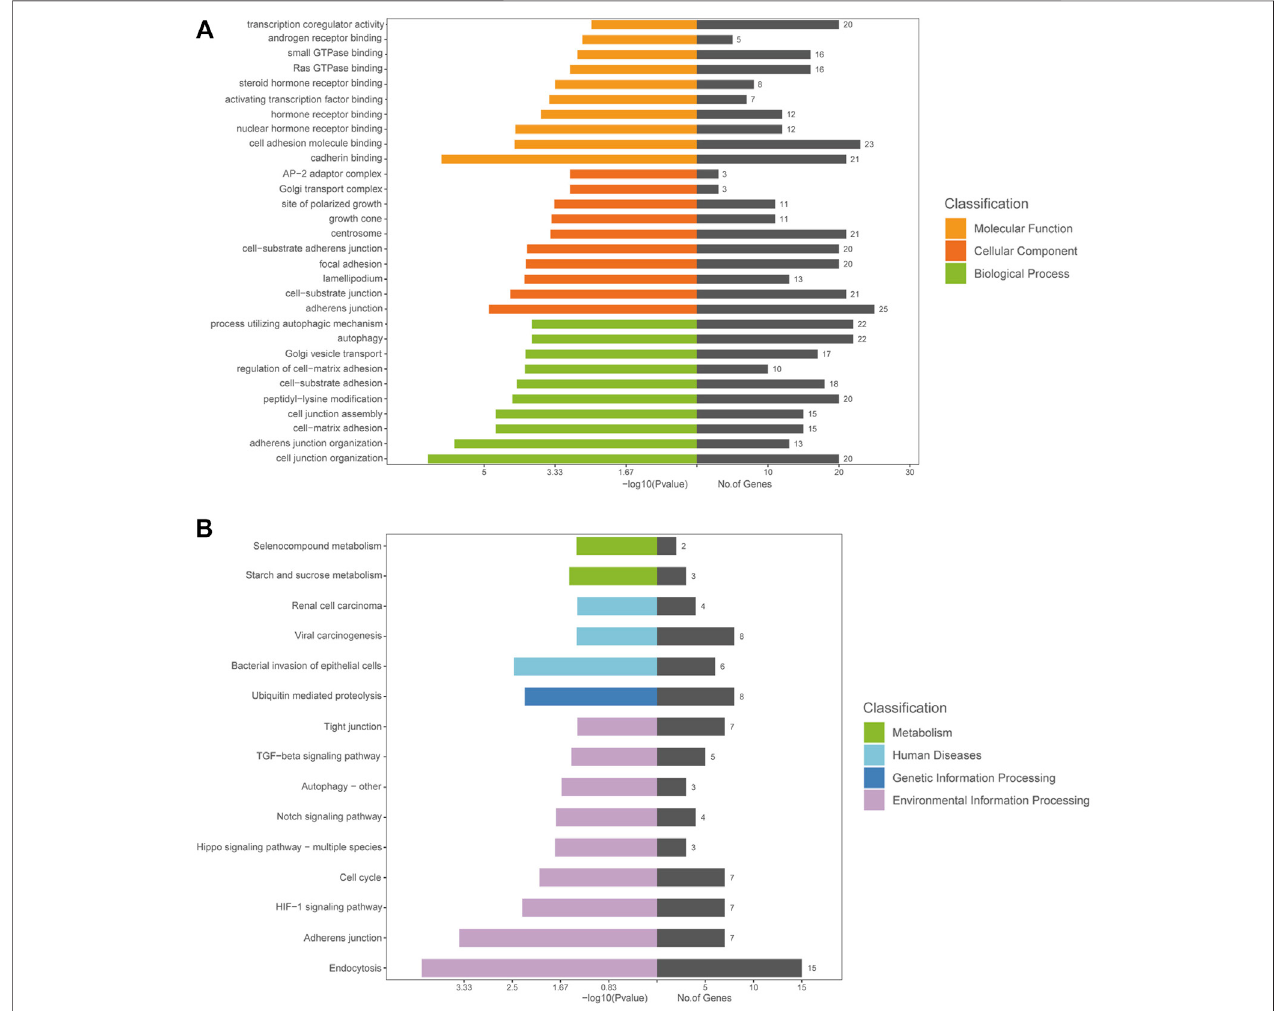
FIGURE 3 | GO and KEGG analyses of the host genes of DE circRNAs in AS-BMSCs. (A) . GO annotations of the host genes of DE circRNAs. The left bar plot presents the enrichment scores [ − log 10 ( p value)] of the top 10 signi fi cantly enriched GO terms in the biological processes, cellular components and molecular functions categories. The bar plot on the right presents the number of genes enriched in each term. (B) . KEGG analysis of the host genes of DE circRNAs.